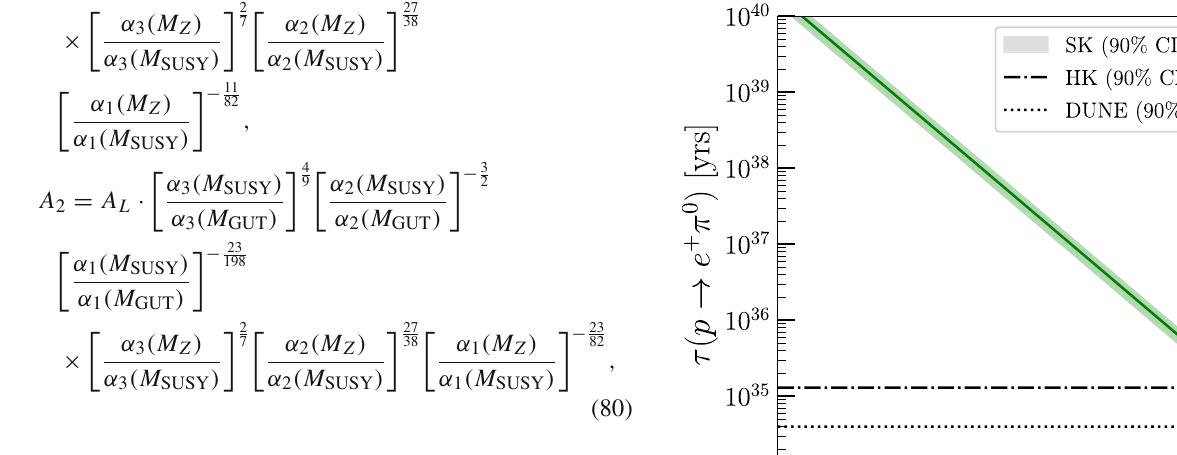
reach of the Hyper-Kamiokande experiment if λ (cid:7) = O ( 1 )